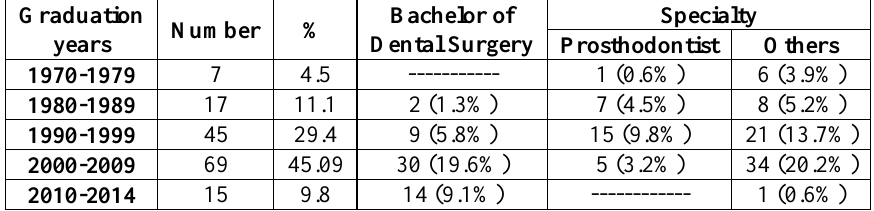
Table 2: Graduation years and specialty of participants